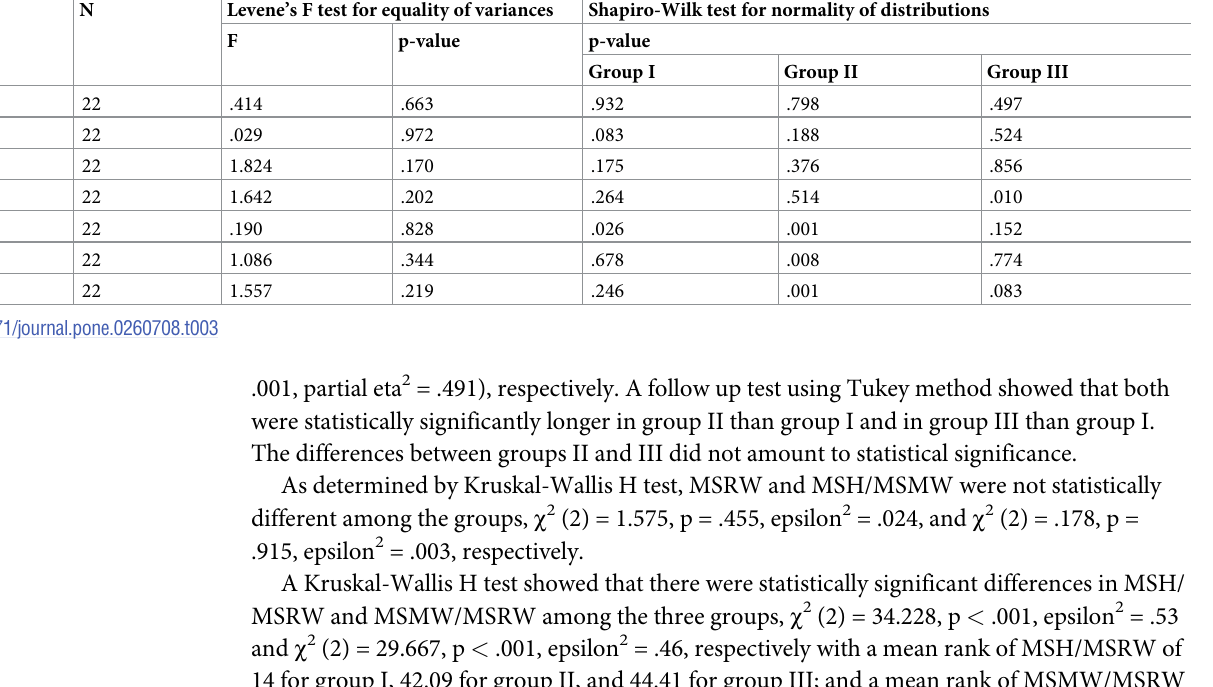
Table 3. Assumptions tests for equality of variances and normality of distributions. Variables